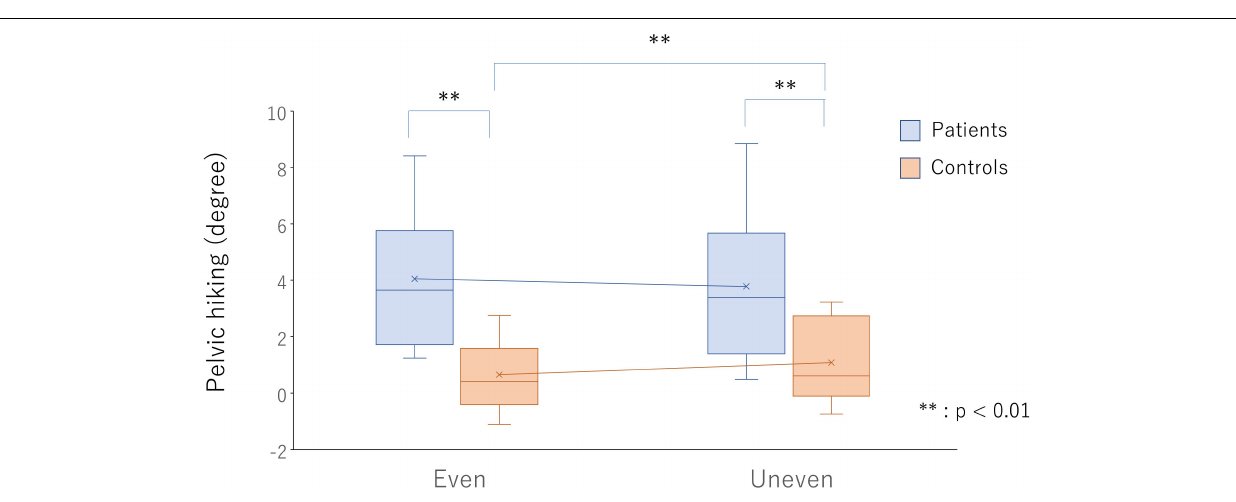
FIGURE 3 | Pelvic hiking on the even surface (bars on the left side) and uneven surface (bars on the right side) in the poststroke patients (light blue bars) and healthy controls (light red bars). ∗∗ p < 0.01 indicate statistical